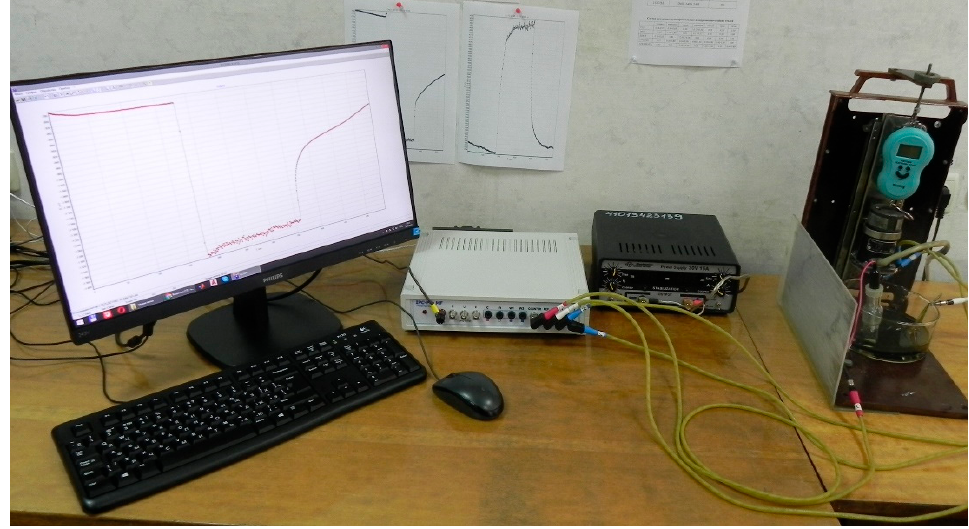
Figure 1. Test facility.